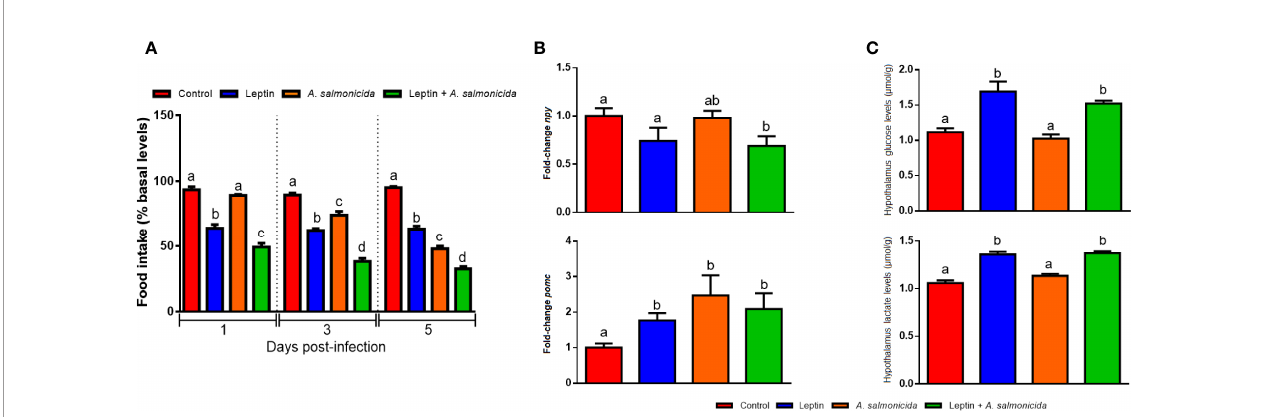
FIGURE 6 | Anorexigenic effects of recombinant human leptin. (A) Effect of the chronic administration of leptin on food intake in the absence or presence of A salmonicida infection. Food intake is represented as the percentage offood ingested with respect to basal levels (calculated as the average offood intake during the three days prior to the experiment). The results are shown as the mean + SEM of the results obtained in three different experiments in which 10 fi sh were used per group in each experiment. Different letters indicate signi fi cant differences (p < 0.05) among treatments at the same post-treatment time. (B) Gene expression analysis of npy and pmoc and (C) glucose and lactate levels in the hypothalamus at 24 h after the i.p. administration of saline solution (control), leptin, A salmonicida or leptin + A salmonicida . For the gene expression data, the expression level of each gene was normalized to the expression of eef1a and expressed as the fold-change with respect to the levels detected in the control group. Each value represents the mean + SEM of n = 6 fi sh per treatment. Different letters indicate signi fi cant differences (p < 0.05) among treatments.